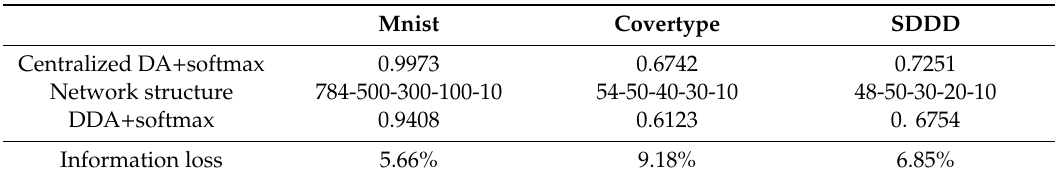
Table 5. Classification accuracy of the centralized and proposed methods (Parameters Setting: 70% training set, 30% validation set, 5-fold cross